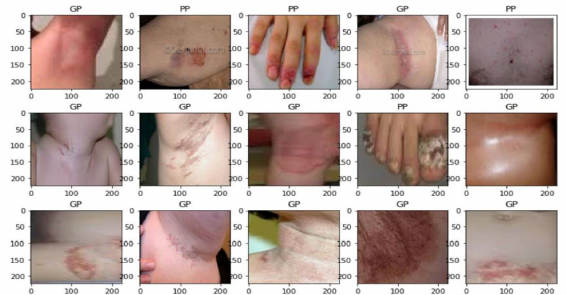
Fig. 2. Training results for the classification of granular parakeratosis and paraneoplastic pemphigus size is 8. In the classification phase, a ratio of 75/25 train- ing and testing images are employed and 10-fold cross- validation is performed.